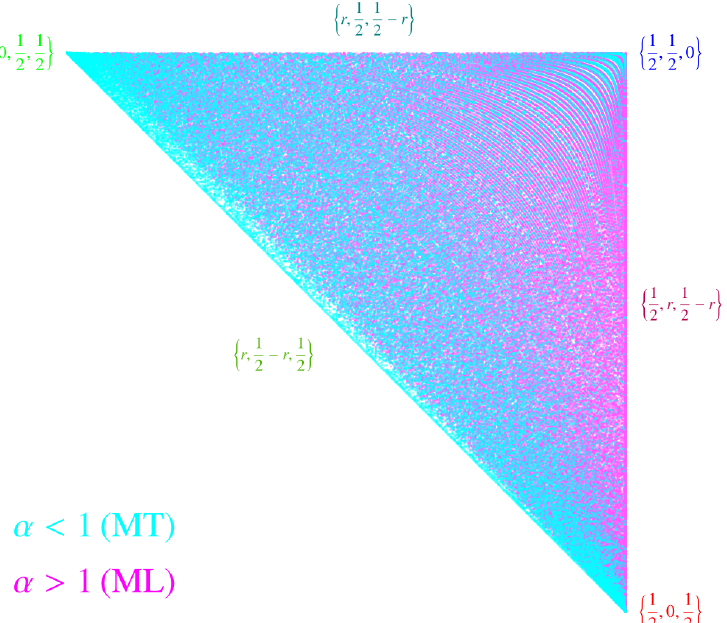
Figure 3. Map of the quantum speed limit (of the states associated to the triads { r i } ) in the 2-simplex δ 2 . For different values of Ω , the simplex is colored according to the range of α (Equation (26)) as follows: the Mandelstam–Tamm subset δ 2 ( α > 1,